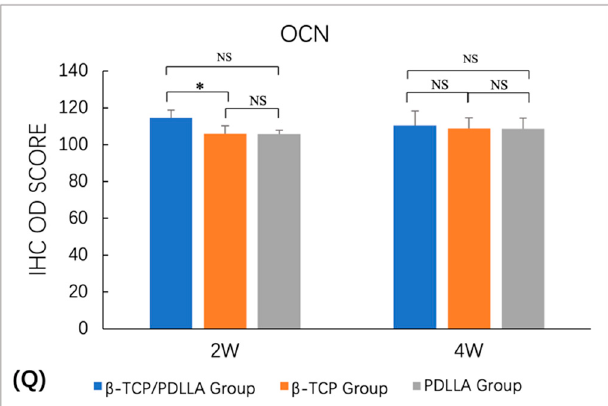
Figure 7. Immunohistochemical staining of OCN in the β -TCP/PDLLA ( n = 3), β -TCP ( n = 3), PDLLA ( n = 3), and sham ( n = 3) groups. ( A – H , E’ – H’ ) sections at 2 weeks after mandibular defect surgery. (I – P , M’ – P’ ) Sections at 4 weeks after mandibular defect surgery. UM, upper mandible; LM, lower mandible; RM, residual material; NB, newly formed bone; CN, connective tissue; OD, optical density. All slices are shown at × 4, × 10 and × 40 magnification. Scale bars: 500 µ m (black), 200 µ m (red), and 50 µ m (blue). ( Q ) The OD of OCN was analyzed using the Kruskal–Wallis test and the pairwise comparisons were used as the post hoc test; * p < 0.05; NS, not significant. Error bars indicate standard deviation.